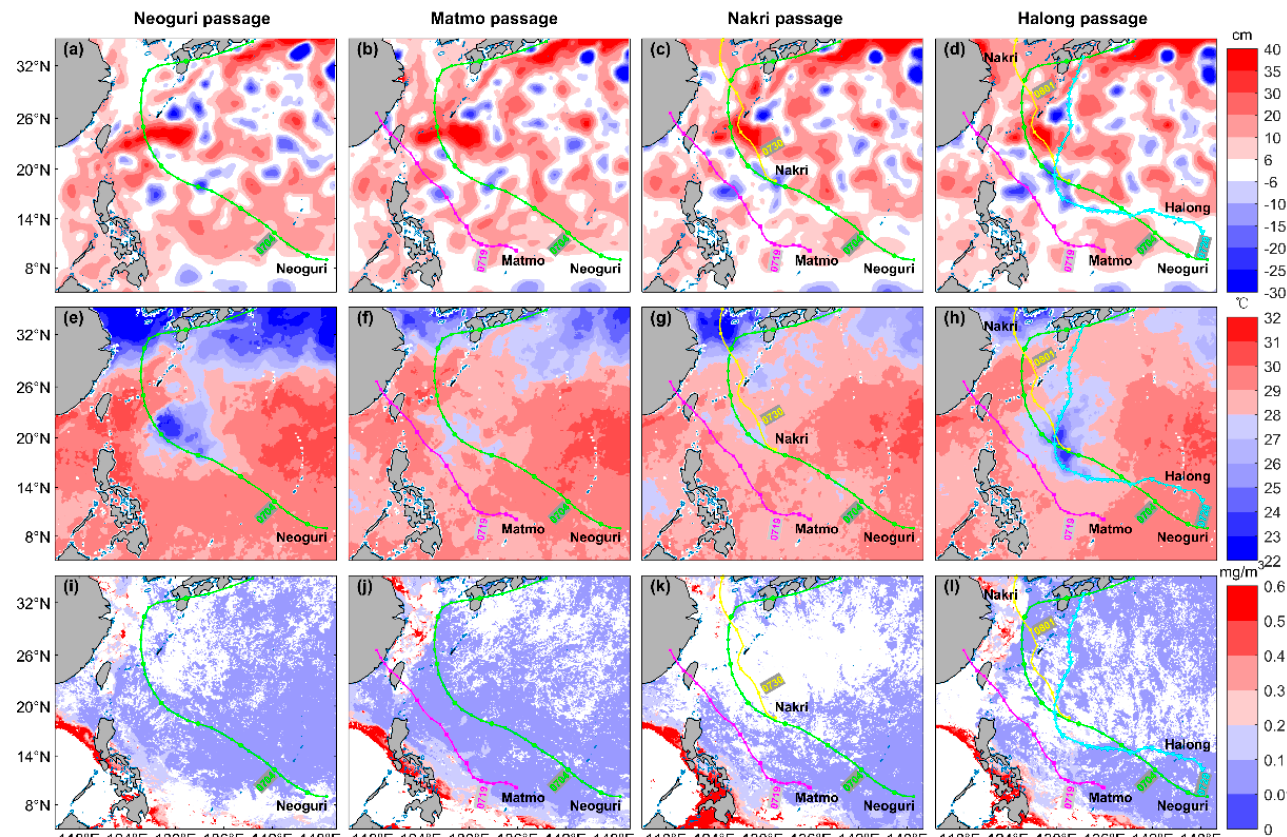
Figure 3. Evolutions of ( a – d ) SSHA, ( e – h ) SST and ( i – l ) chl-a concentration after the passage of each typhoon during four sequential TCs. The colored lines represent the TC tracks.